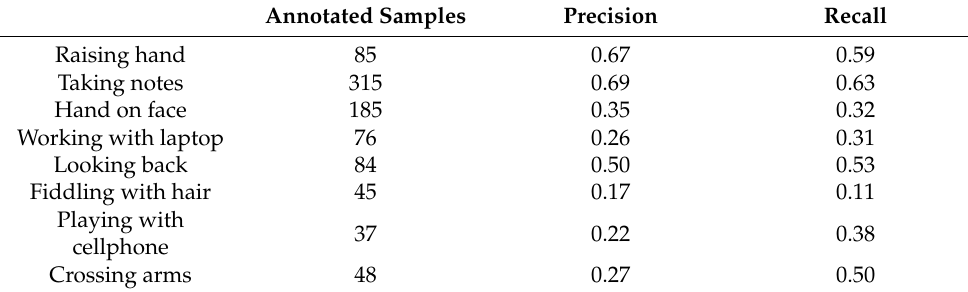
Table 1. Binary action classification on top of i3D features for each class. Annotated